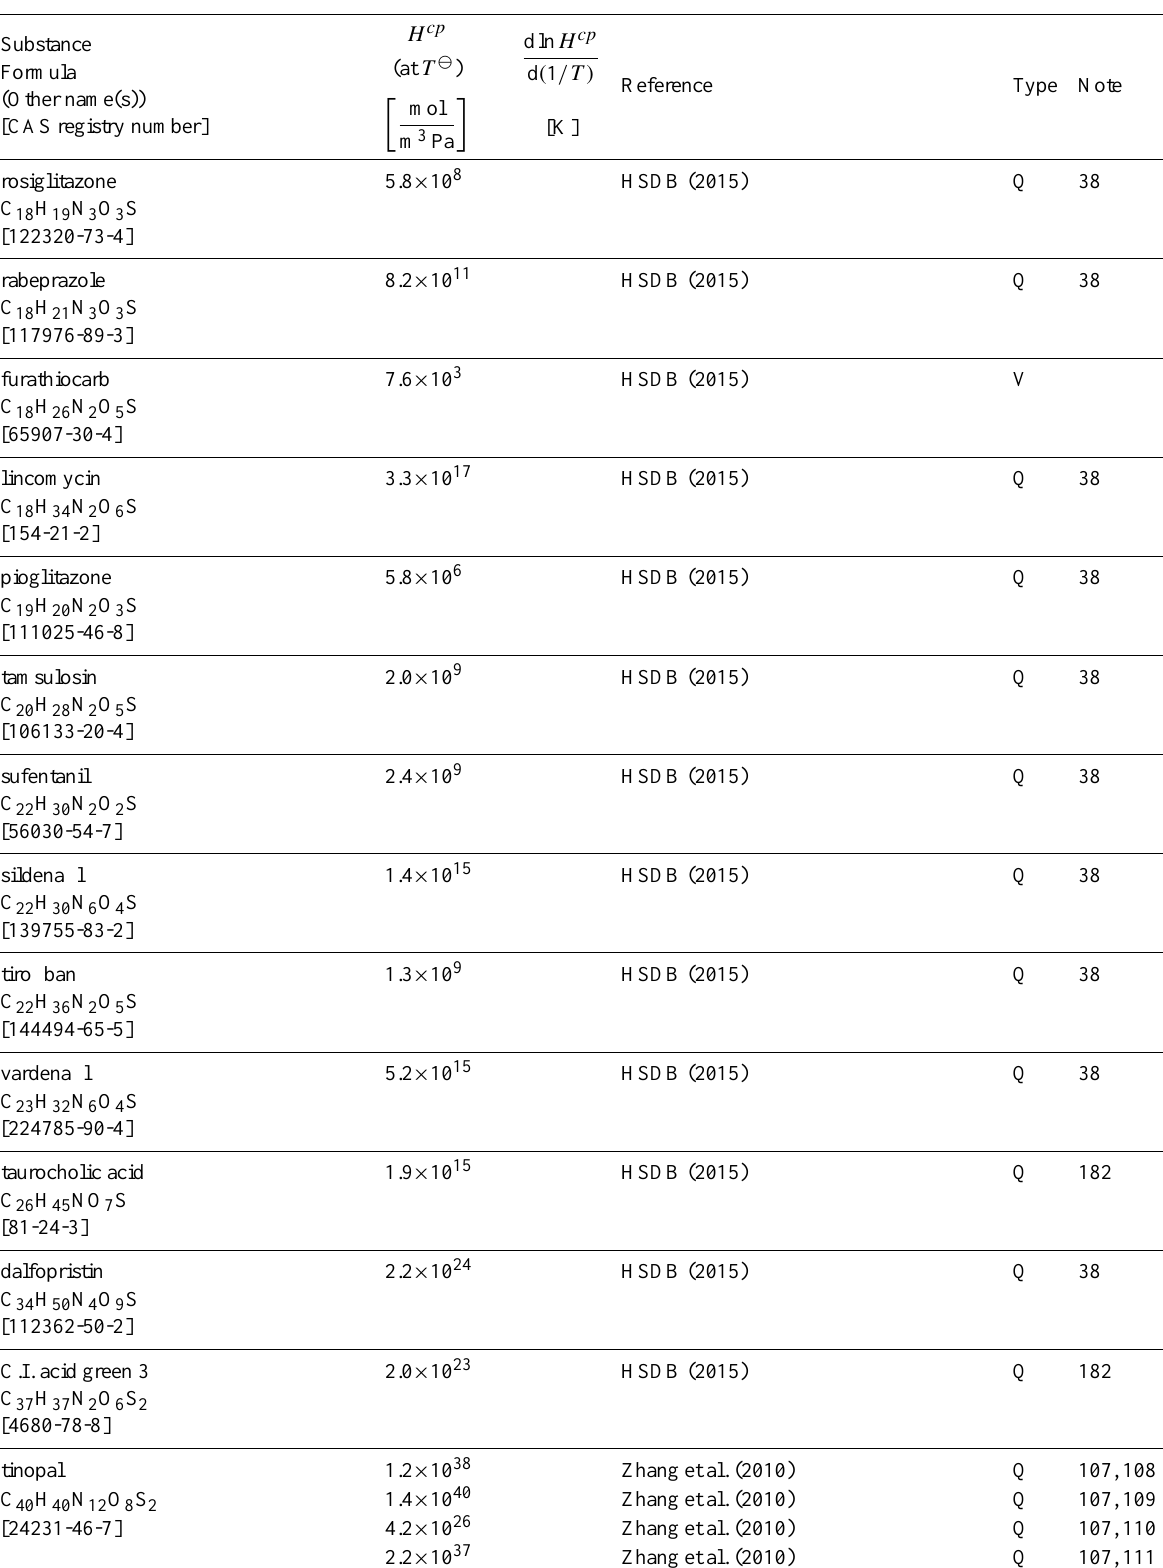
Table 6: Henry’s law constants for water as solvent